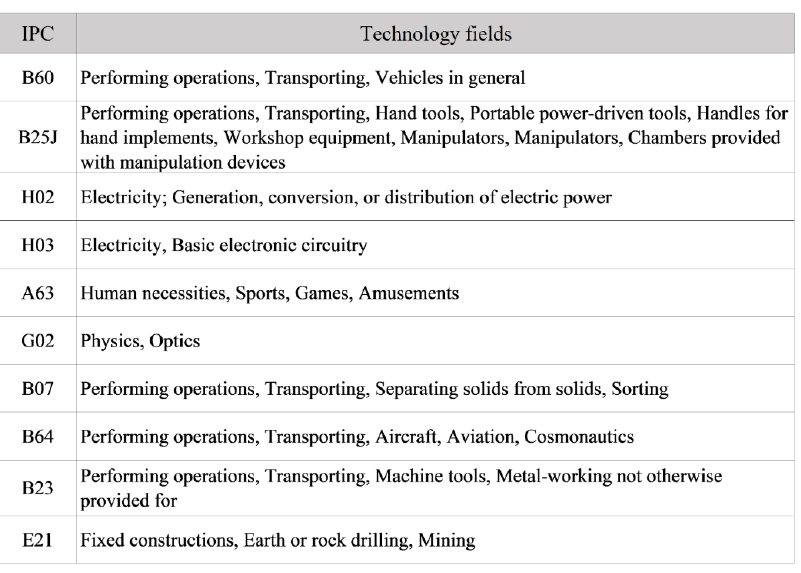
Fig. 14 Distribution of IPC in other fields.